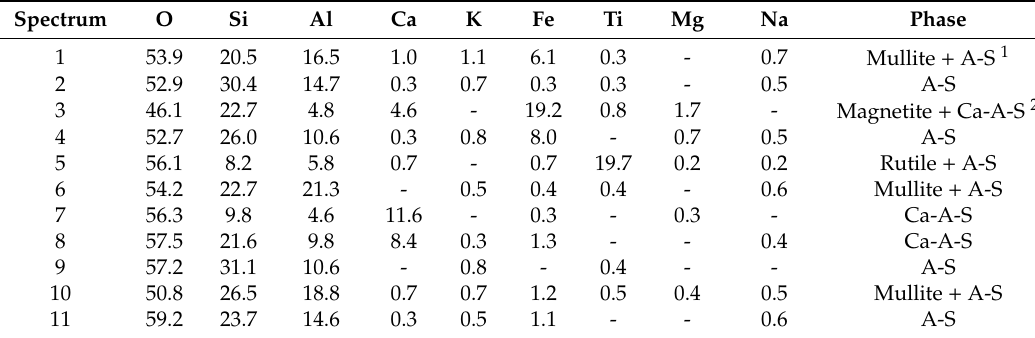
Table 2. The elemental compositions (wt.%) of CFA particles (see Figure 3 for the spectra numbers). Spectrum O